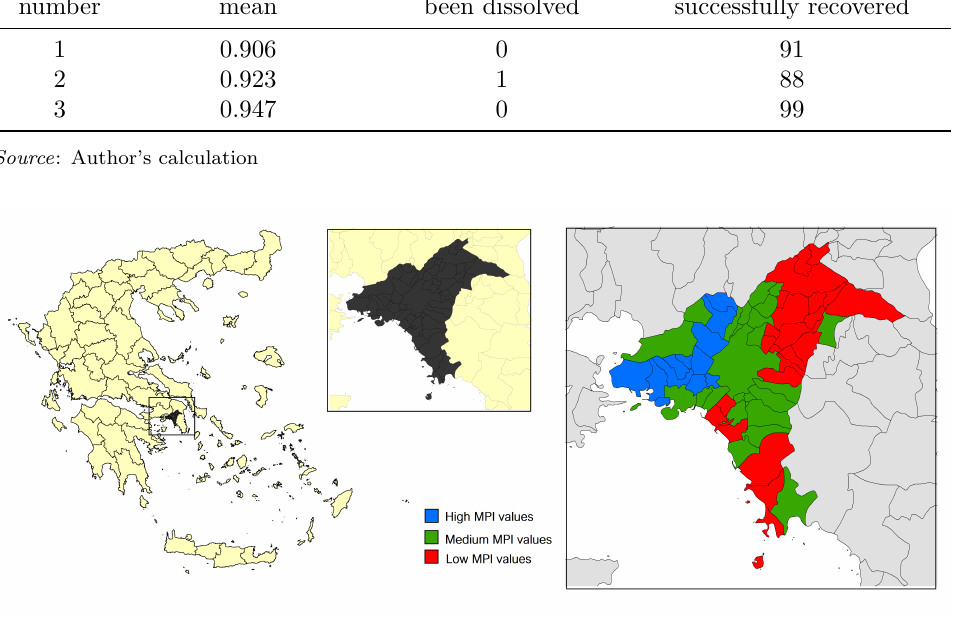
Figure 7: Map illustrating three main clusters arising within the metropolitan area of Athens based on MPI values